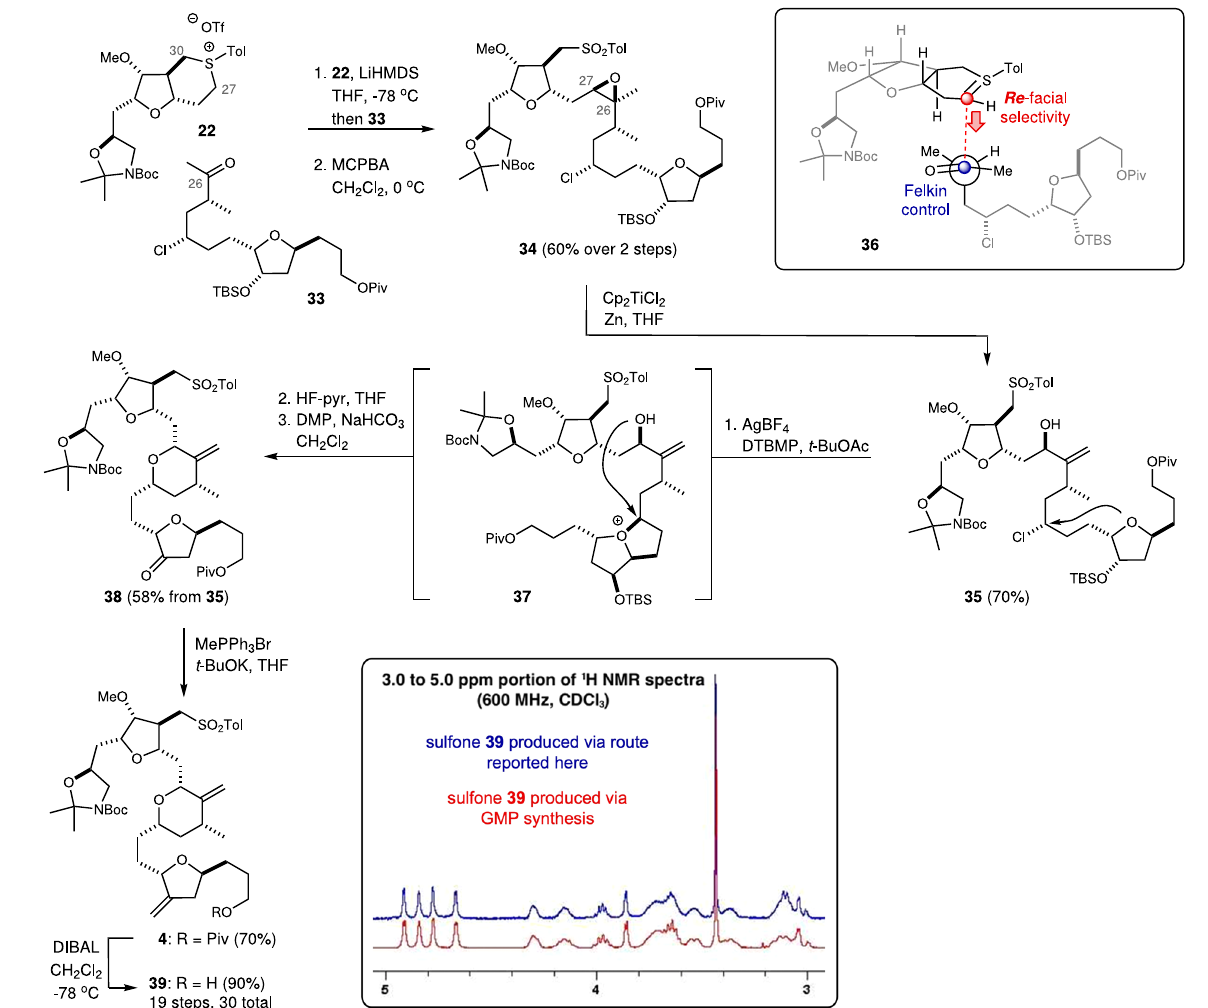
Fig. 4 | Synthesis of the C14 – C35 Alphora sulfone 4. A doubly